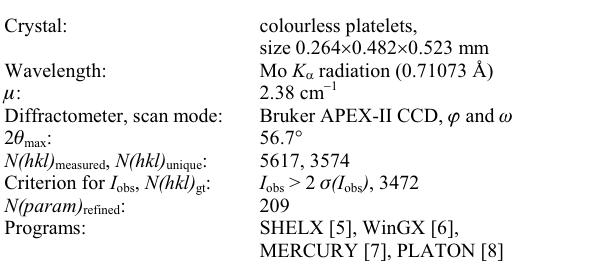
Table 1. Data collection and